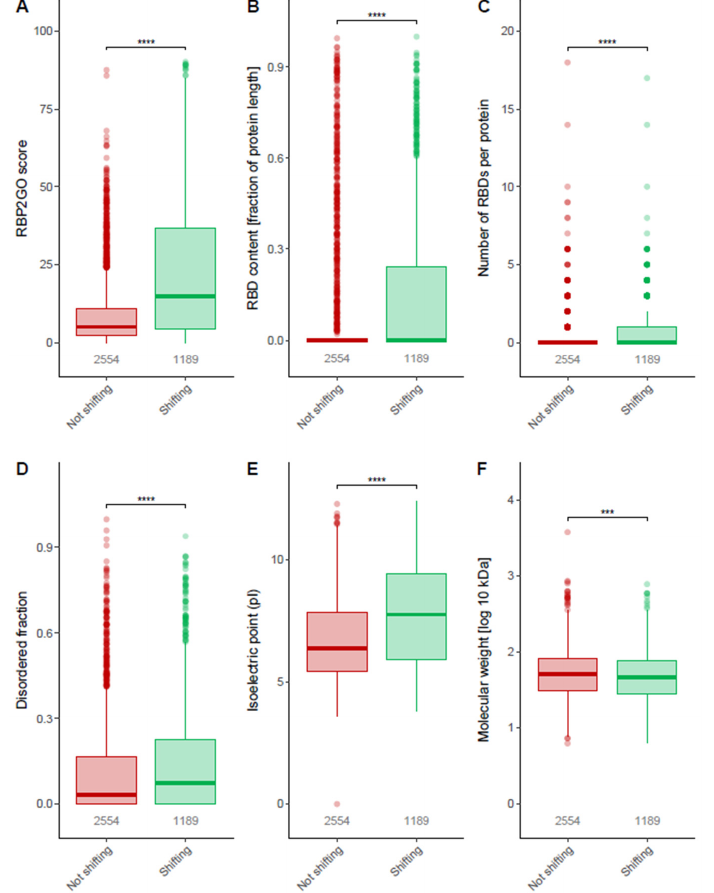
Figure 3. Properties of shifting proteins: ( A ): RBP2GO score of shifting vs. non-shifting proteins. ( B ): RNA binding domain (RBD) content fraction in shifting vs. non-shifting proteins. ( C ): Number of RBDs present in shifting vs. non-shifting proteins. ( D ): Intrinsically disordered region fraction in shifting vs. non-shifting proteins. ( E ): Isoelectric points (pI) of shifting vs. non-shifting proteins. ( F ): Molecular weight of shifting vs. non-shifting proteins. All: Data presented as boxplots with the bar indicating the median and the box indicating the lower and upper quartiles. The upper whisker extends from the hinge to the largest value not more than 1.5 × interquartile range from the hinge and the lower whisker extends from the hinge to the smallest value at most 1.5 × interquartile range of the hinge. The outliers are represented by dots. Wilcoxon test was used to calculate the p -value, (*** p < 0.001, **** p (cid:3409) 0.0001). For the validation of the RNA-dependent shifting and direct RNA-binding, we se- lected protein candidates based on the following criteria: proteins that had never been identified as RNA-binding before according to 43 human studies compiled in the RBP2GO database [29], the strength of the shift (distance, peak gain/loss) and the availability of suitable antibodies resulting in the selection of DOCK5, ELMO2 and ABRAXAS1 (CCDC98) for further analysis.